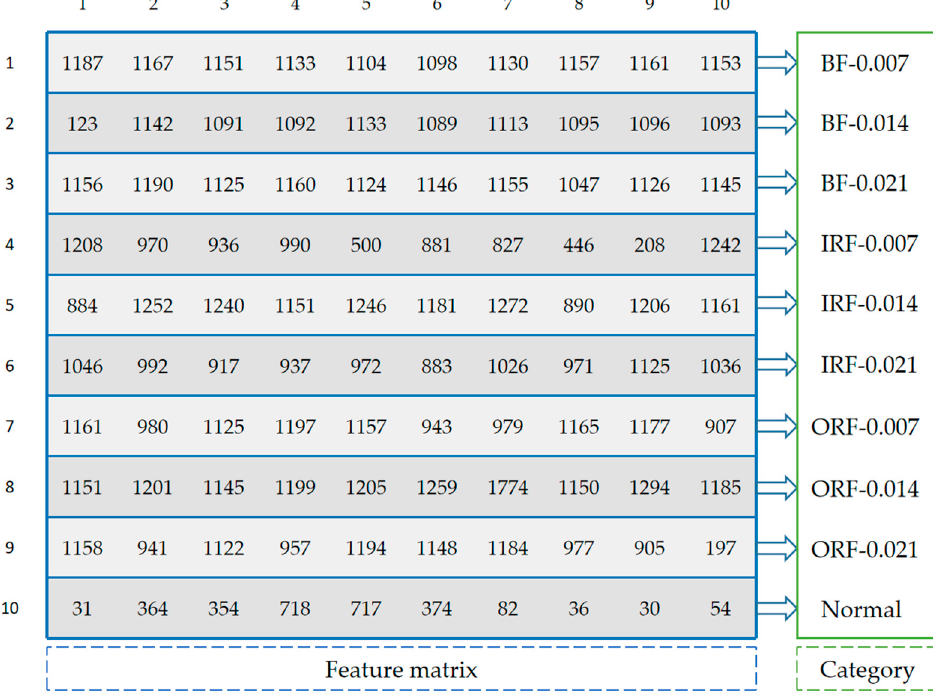
Figure 9. The detailed feature matrix in Figure 7c, obtained from the training of FDFM in which each sample has 4096 points.